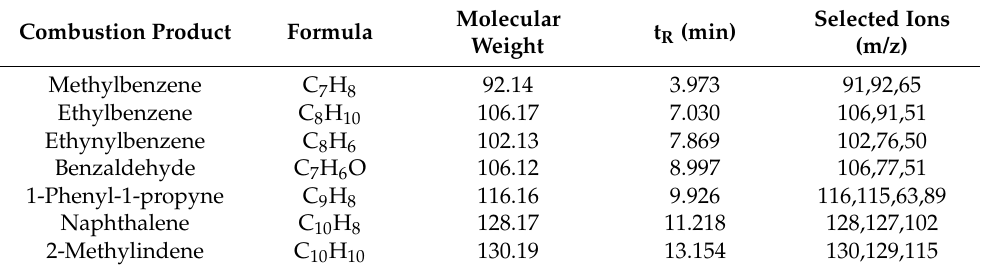
Table 1. List of combustion products in a gas cloud using gas chromatography coupled with mass spectrometry (GC–MS). Combustion Product Formula